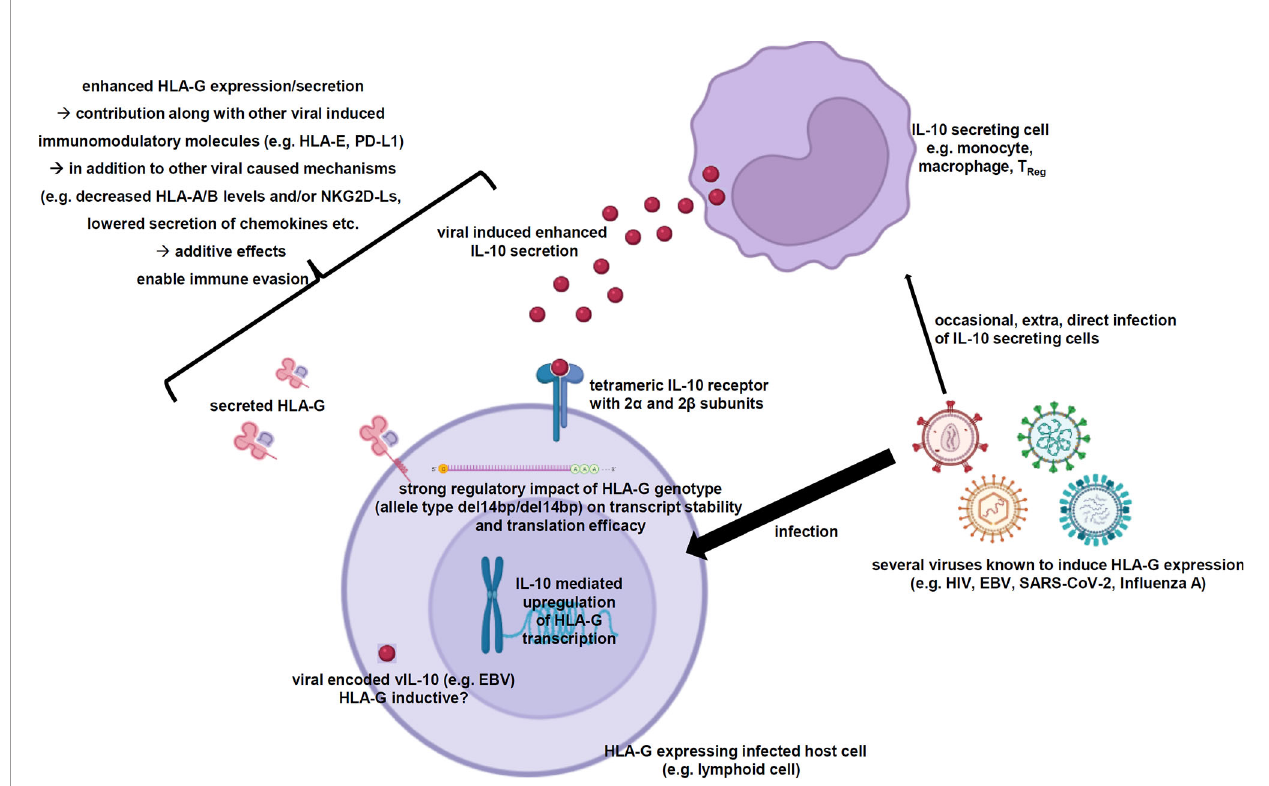
FIGURE 2 | Scheme summarizing the virus-induced enhanced IL-10 secretion resulting in elevated HLA-G expression and secretion. The working hypothesis demonstrates the elevated IL-10 secretion of certain immune effector cells as consequence of viral infections, which is very likely the main driver of the increased HLA-G gene expression and secretion within the virally infected host cells strongly contributing to immune evasion. Created with